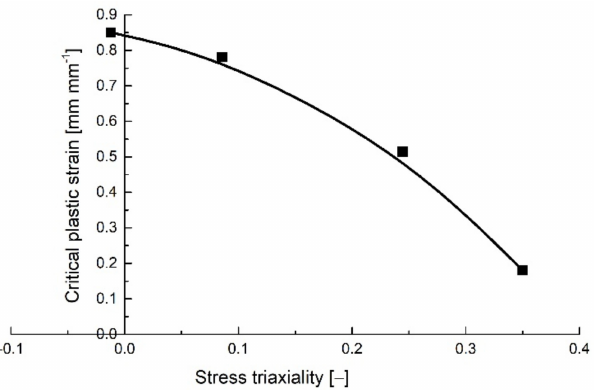
Figure 17. Variation of the critical equivalent plastic strain with stress triaxiality for the Arcan tests.